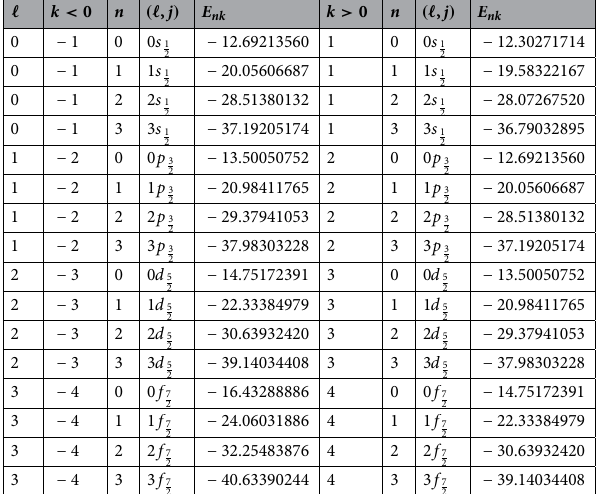
1 , v 1 , b 5 fm 15 fm 0.1, 1 − − = = =